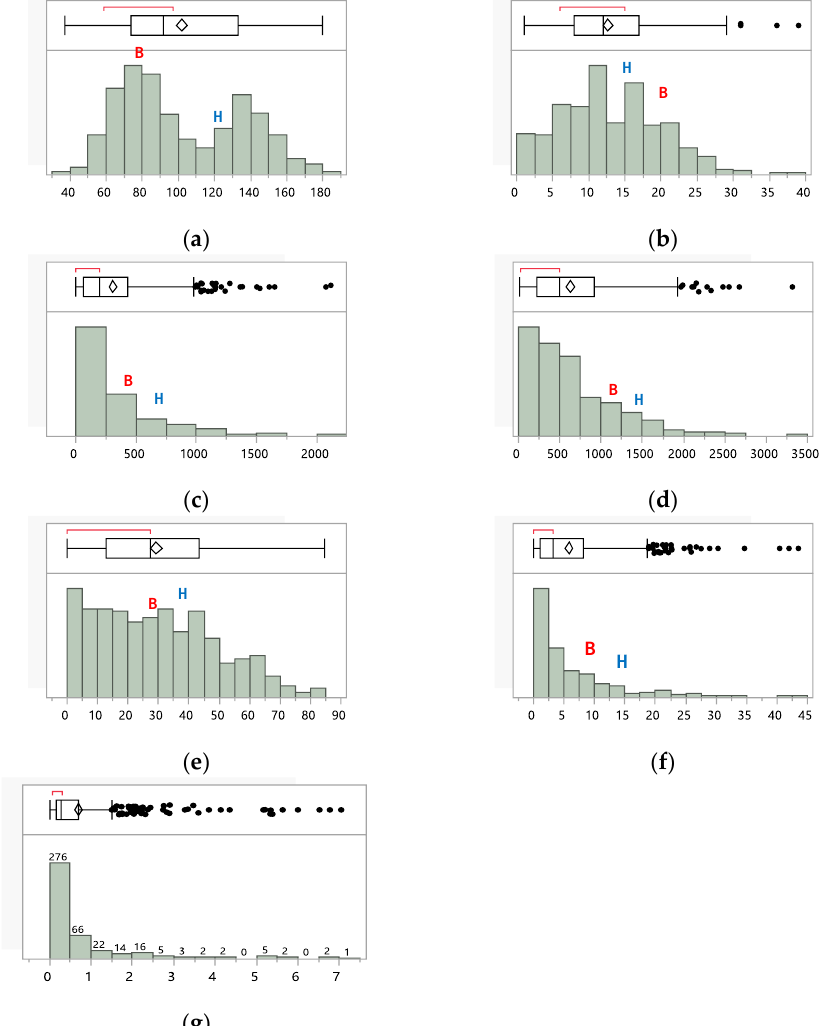
Figure 3. Trait frequency distribution of the agronomic traits and Na + -K + ratio of the 435 BC 1 F 2 progenies grown under salinity stress of EC 10 dS/m at the reproductive stage. The parental means are also shown: BRRI dhan28 (B) and Hasawi (H).( a ) Plant Height (cm). ( b ) Productive Tiller (no/plant). ( c ) Filled Spikelets (no/plant). ( d ) Unfilled Spikelets (no/plant). ( e ) Filled Spikelets (%). ( f ) Grain Yield (g/plant). ( g ) Na + -K + Ratio.